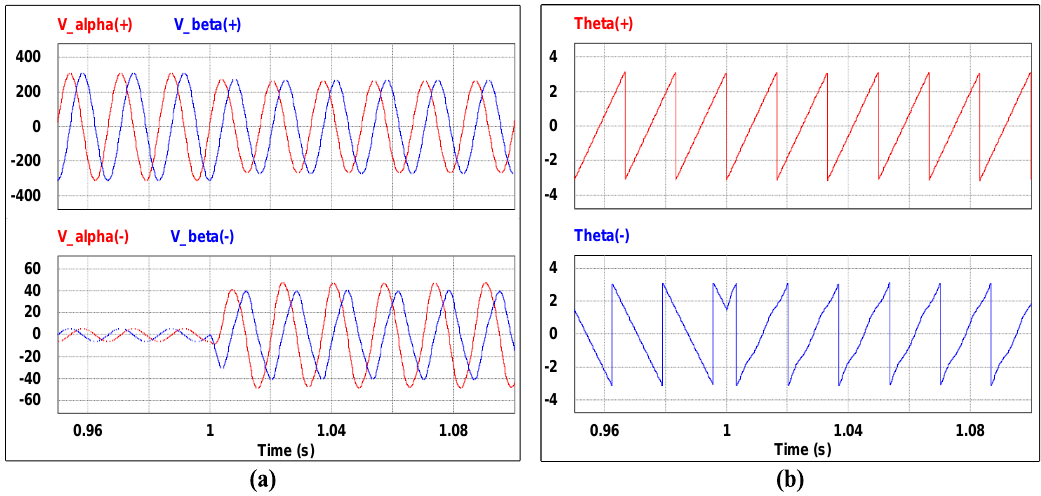
Figure 19. Waveforms of simulation results when voltage drop is occurred; ( a ) the positive and negative sequence voltage; and, ( b ) the phase angle of the positive and negative sequence voltage.